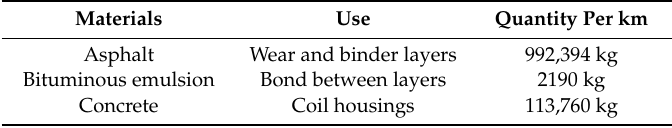
Table 2. The materials per km of